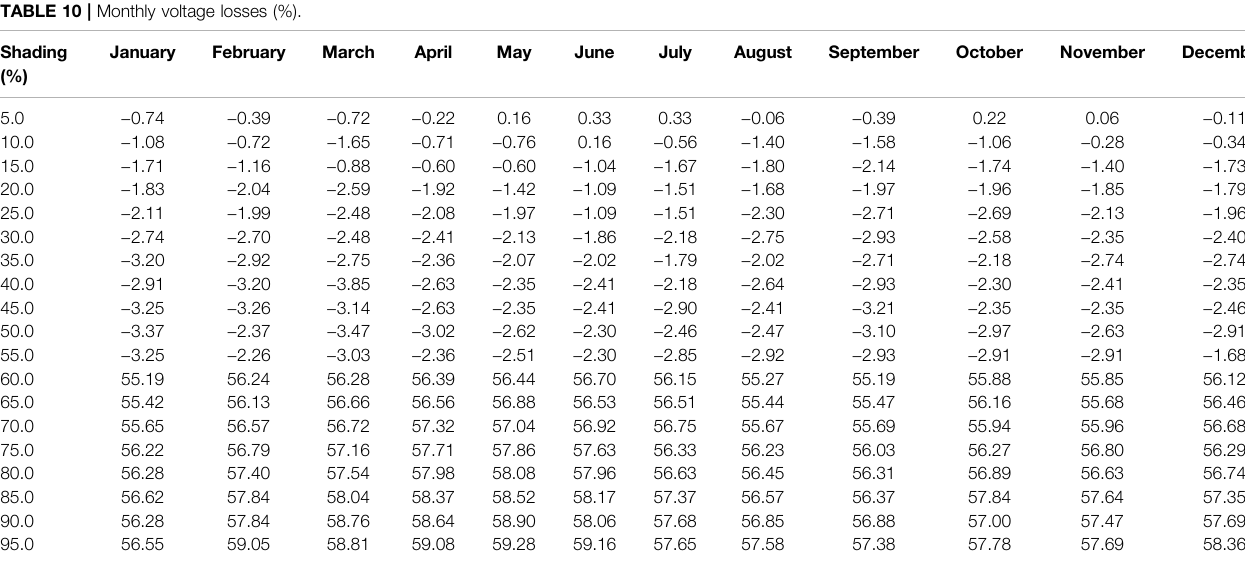
TABLE 10 | Monthly voltage losses (%). Shading